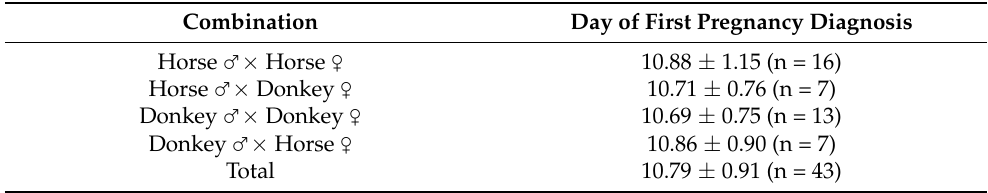
Table 4. Day of first embryo detection (mean ± SD) in horse and donkey females inseminated with horse and donkey semen ( p >